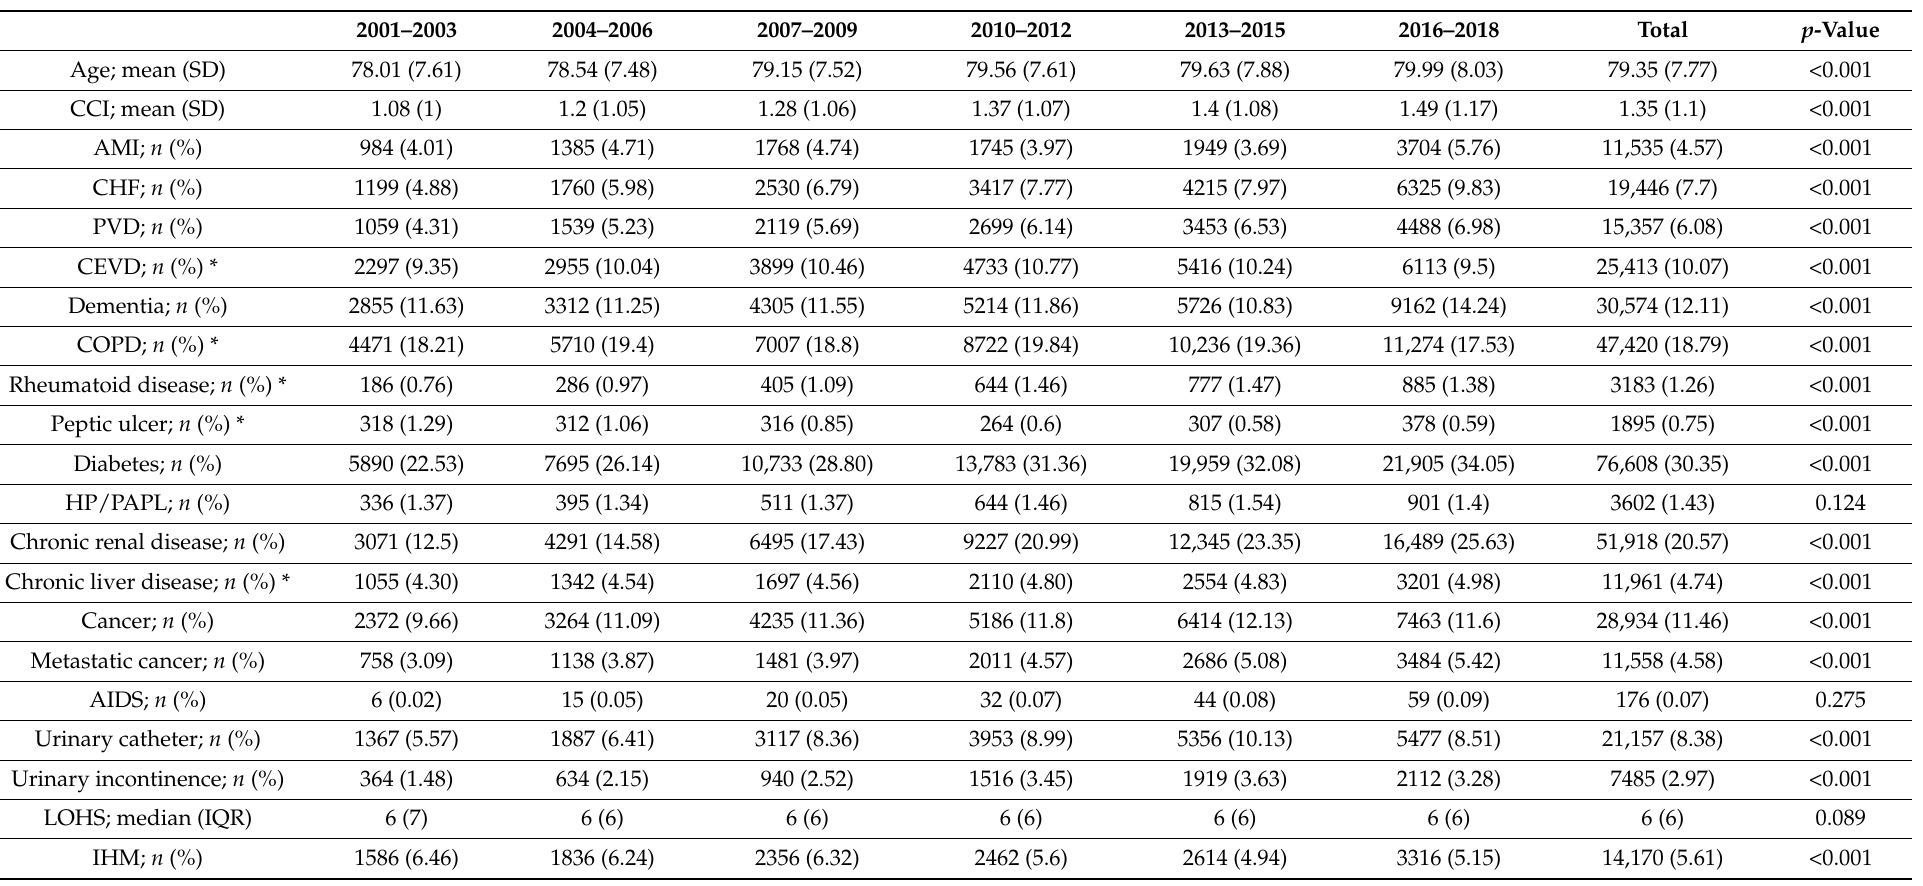
Table 2. Clinical characteristics and hospital outcomes for admissions of elderly men with a principal diagnosis of urinary tract infection in Spain